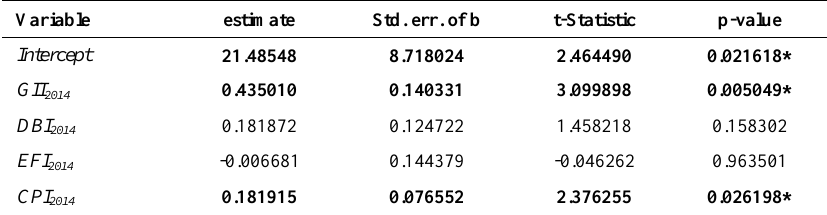
Table 3. The statistical output of the estimated variables for GCI score in 2014 Variable